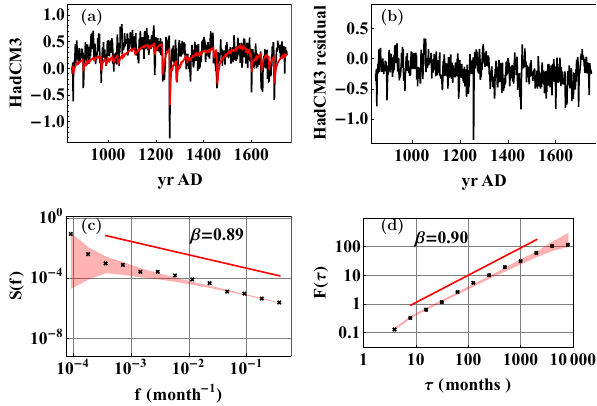
Figure 13. (a) The temperature from the HadCM3 experiment (black) and deterministic response (red). (b) The residual from the deterministic response. (c) PSD from the residual (black crosses) and linear fit to the PSD in the scale range indicated by the red line segment. The value β = 0 . 89 estimated from this line segment is indicated in the figure. (d) DFA2 applied to the residual (black crosses). The straight line segment is a linear fit to the dots in the range indicated by the length, and position of the line segment and the slope yields an alternative estimate β = 0 . 90 for the residual, indicated in the figure. The shaded areas in (c) and (d) show the 95% confidence range for synthetic fGn with β = 0 . 82 estimated by MLE using the response model.